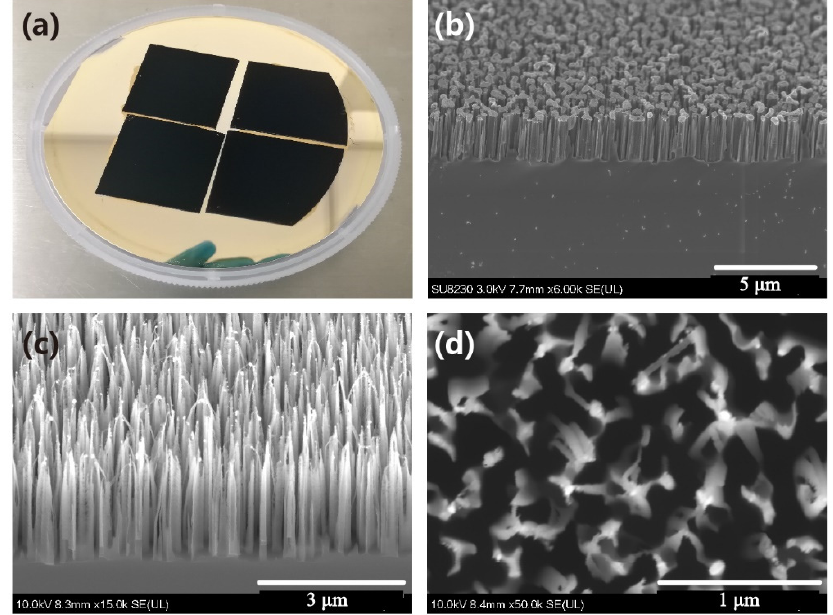
Figure 2. Photograph and SEM images of the silicon nanowires. ( a ) Photograph; ( b ) nanowires with Au nanoparticles on tip top; ( c ) tilted image of the nanowires formed through 120 loops of Bosch process; ( d ) top view of the nanowires formed through 120 loops of Bosch process.